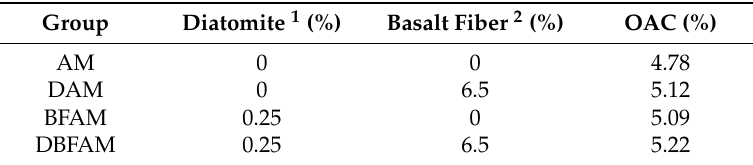
Table 5. Experimental design of asphalt mixtures. AM: control asphalt mixture; DAM: diatomite modified asphalt mixture; BFAM: basalt fiber modified asphalt mixture; DBAFM: diatomite and basalt fiber compound modified asphalt mixture.